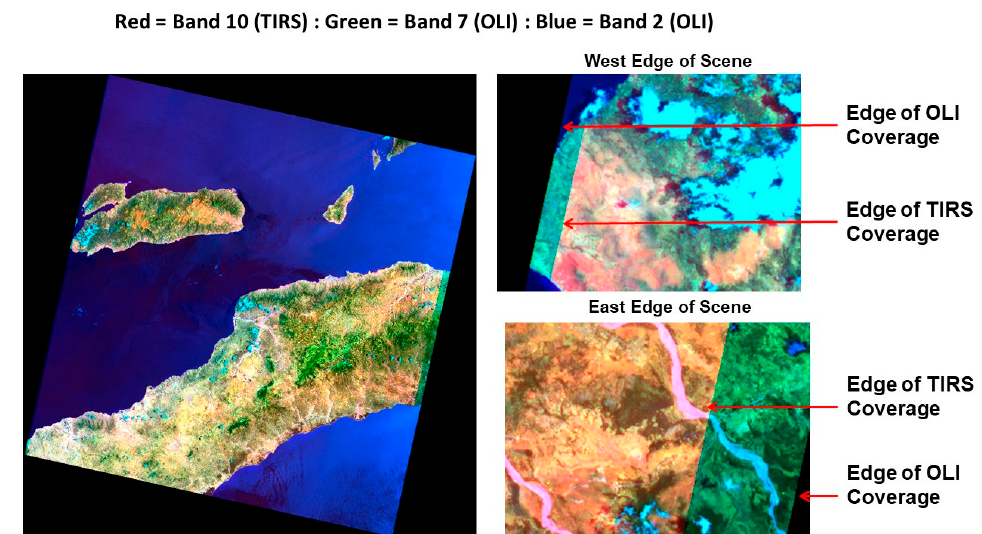
Figure 1. Red, green, blue (RGB) image containing thermal infrared sensor (TIRS) band 10 for the red channel, operational land imager (OLI) band 7 for the green channel, and OLI band 2 for the blue channel. RGB image demonstrates the overlap between the TIRS and OLI instruments showing that the TIRS instrument field of view is contained within the OLI instrument field of view.